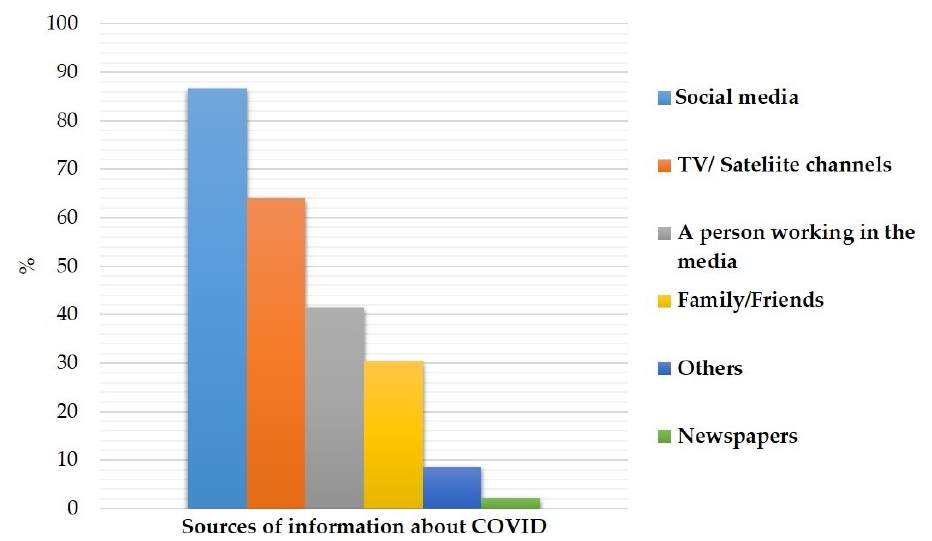
Figure 1. Sources of information about